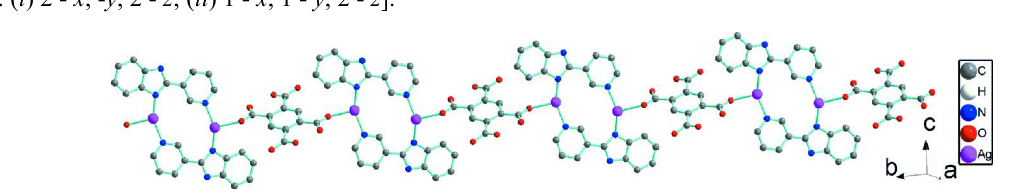
Figure 2 A view of the one-dimensional chain of (I). H atoms are omitted for clarity.